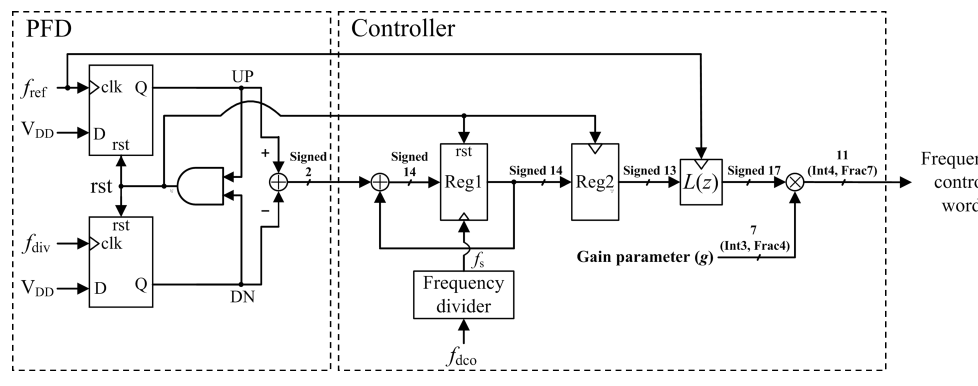
Figure 4. Architecture of the PFD and controller.